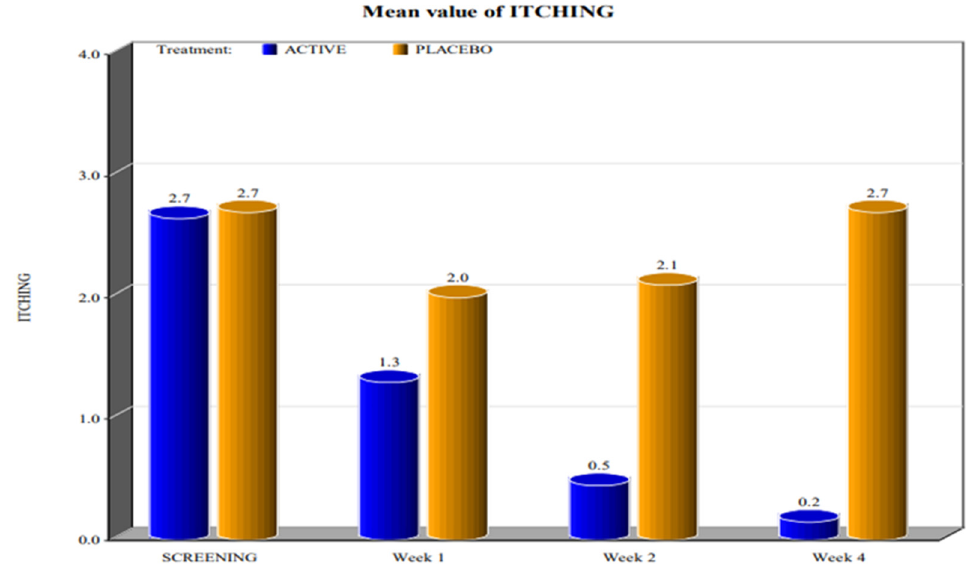
Figure 3. Mean value of itching ( p value < 0.0001).